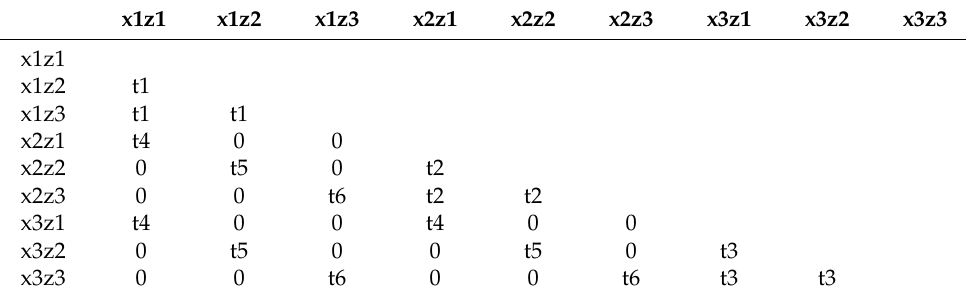
Table 1. The matrix of residual covariances for the latent interaction models. Note, covariances with the same label are constrained to equality. x1z1 x1z2 x1z3 x2z1 x2z2 x2z3